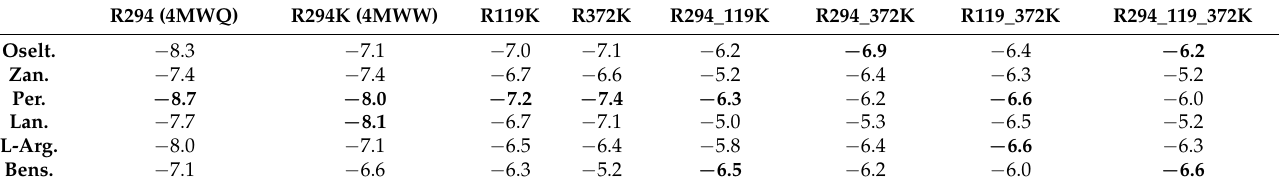
Figure 1. ( A ) Superposition of the drug Oseltamivir inside the binding pocket of native crystal structure of 4MWQ shown in green and the re-docked complex using “AutoDock” is shown in deep salmon (RMSD: 1.0). ( B ) Superposition of the drug Oseltamivir inside the binding pocket of native crystal structure of 4MWQ shown in green and the re-docked complex using “GOLD” is shown in orange (RMSD: 0.5). ( C ) Superposition of the drug Oseltamivir inside the binding pocket of the native crystal structure of 4MWQ shown in green and the re-docked complex using “MOE” is shown in blue (RMSD: 0.4). Table 1. Lowest binding energies according to AutoDock software 1 .